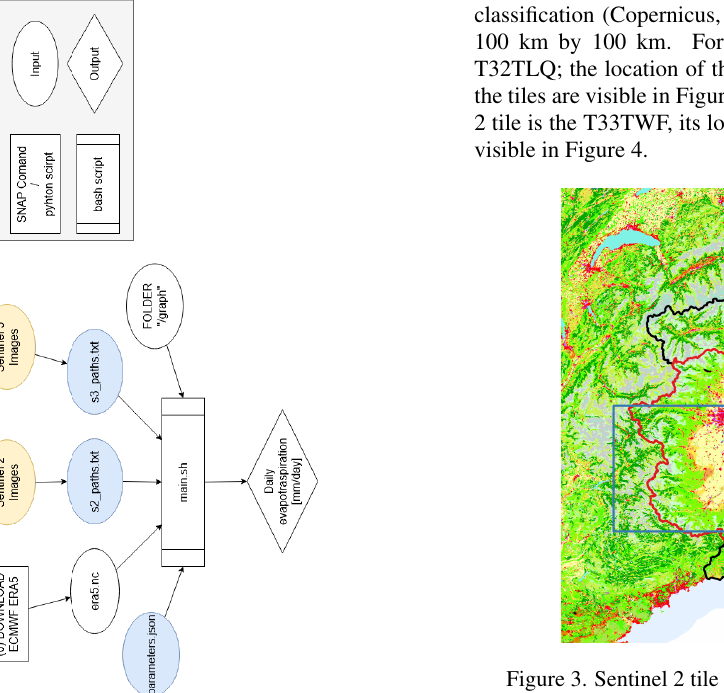
Figure 3. Sentinel 2 tile T32TLQ location and land cover.